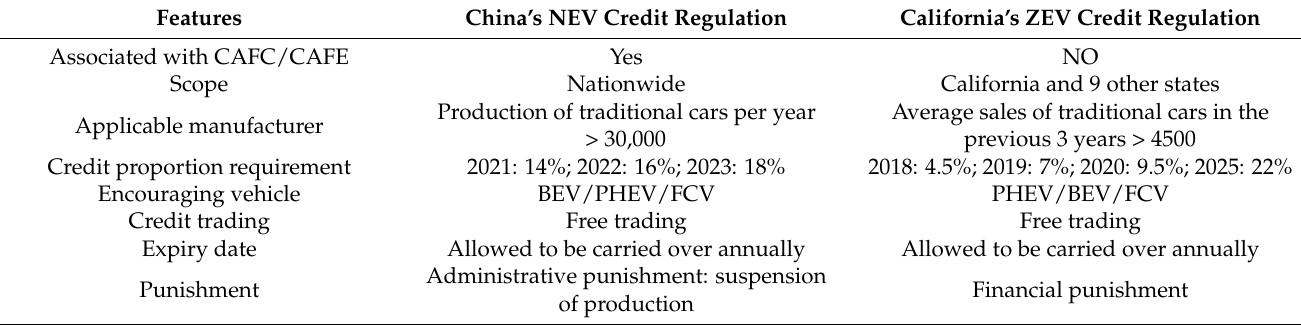
Table 1. Comparison between China’s NEV and California’s ZEV credit